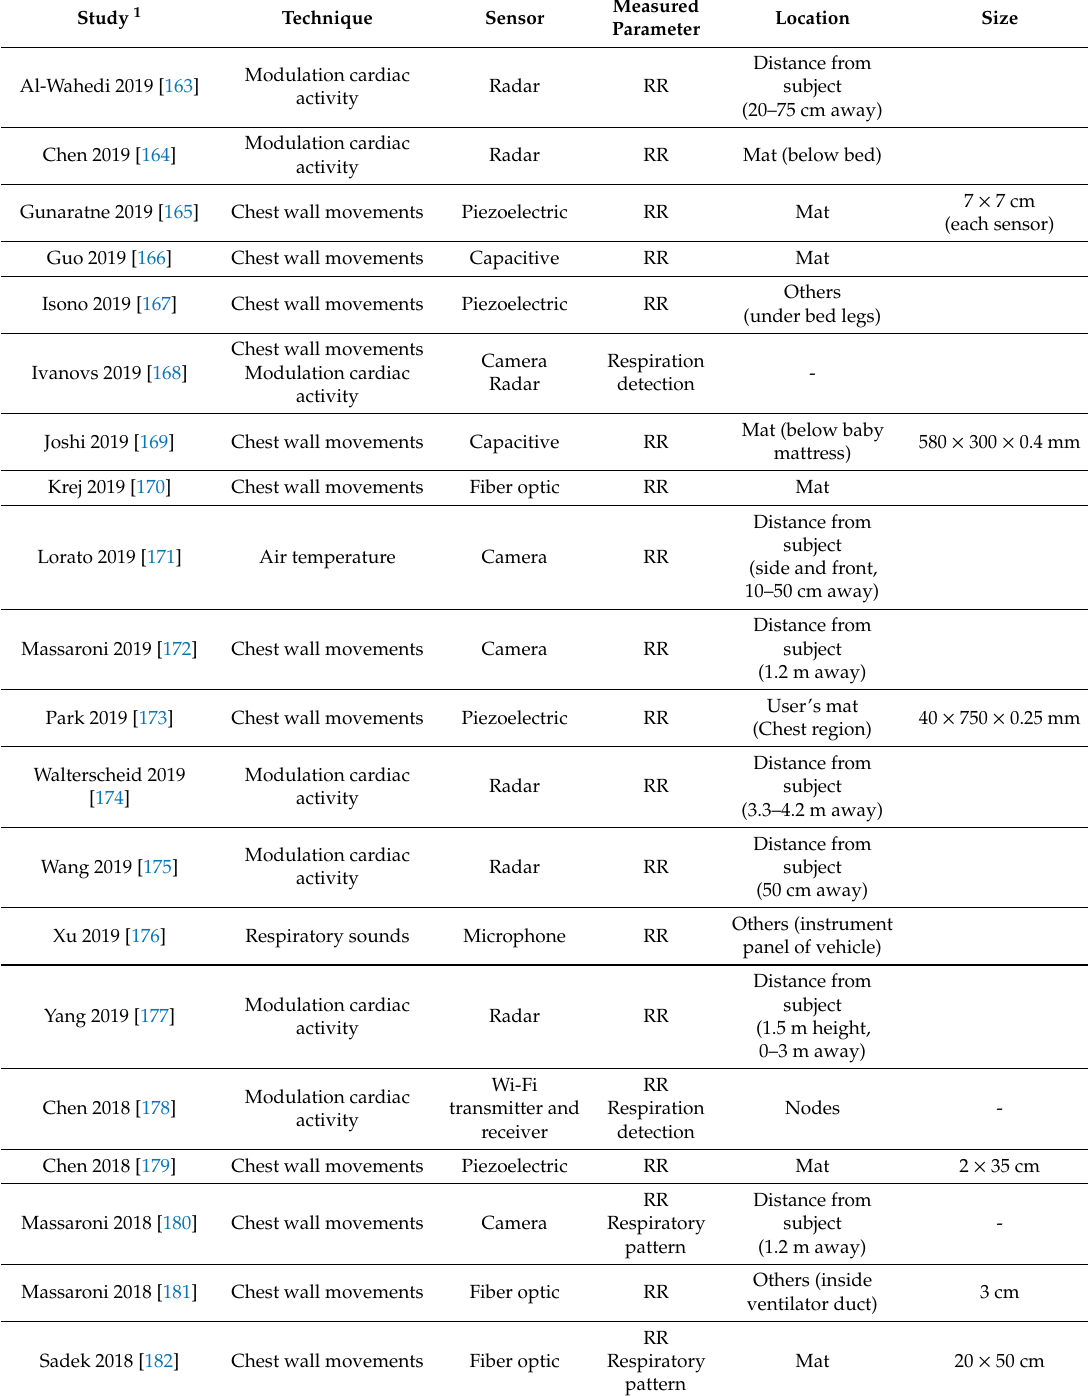
Table 2. Analysis of sensing techniques, sensors, breathing parameters, and sensor location and size for studies of the environmental